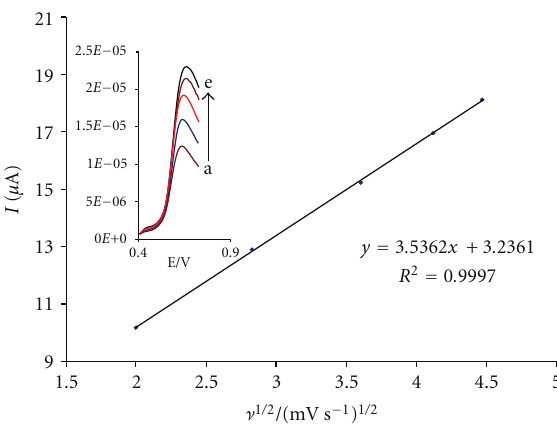
Figure 3: Plot of I pa versus ν 1 / 2 for the oxidation of 150 μ M Hcy in the presence 400 μ M CHP at the surface of MWCNTPE. Inset: linear sweep voltammetry of 150 μ M Hcy in the presence 400 μ M CHP at